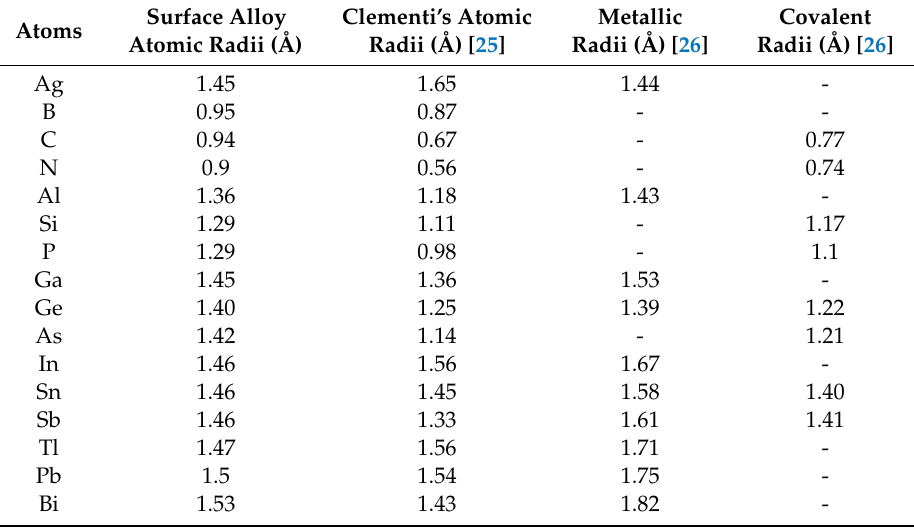
Table 2. Comparison of calculated atomic radii of surface alloy atomic radii and